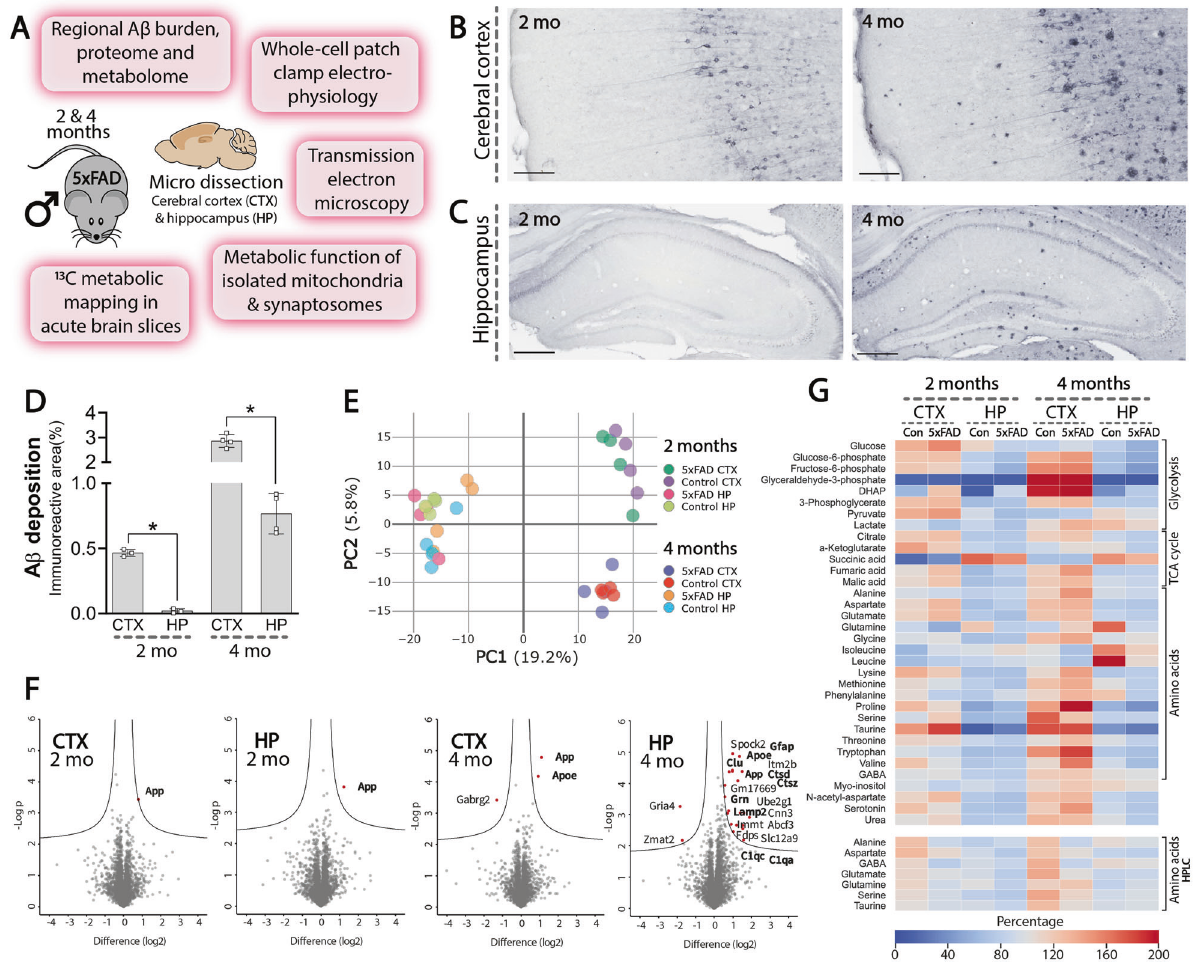
Fig. 1 Hippocampal and cerebral cortical amyloid- β (A β ) burden, proteome and metabolome of 5xFAD mice. A Experimental overview of the study: male 5xFAD and control mice were utilized at 2 and 4 months (mo) of age. Representative A β staining of the cerebral cortex ( B ) and the hippocampus ( C ) of 2 and 4 mo old 5xFAD mice. Scale bars: B : 100 µm, C : 250 µm. D Quanti fi cation of regional A β immunoreactive areas in the cerebral cortex and hippocampus of the 5xFAD mice, mean ± SEM, n = 3-4, Student ’ s paired t -test. E Principal component analysis (PCA) plot of the 5xFAD proteome shows distinct clustering of samples based on brain region and age, n = 4. F Volcano plots displaying signi fi cant alterations in protein expression in the 5xFAD hippocampus and cerebral cortex. Proteins in the upper left quadrant signify decreased expression, whereas protein in the upper right quadrant signify increased expression. Statistical analysis of the proteome and metabolome is described in detail in the ‘ Materials and methods ’ section. G Heatmap displaying normalized metabolite abundance of glycolytic and TCA cycle intermediates, amino acids and other metabolites in microwave fi xated brain tissue from 5xFAD mice, n = 6 – 7, Student ’ s paired t -test. Blue tones denote reduced abundance, whereas red tones denote elevated abundance. CTX: cerebral cortex, HP: